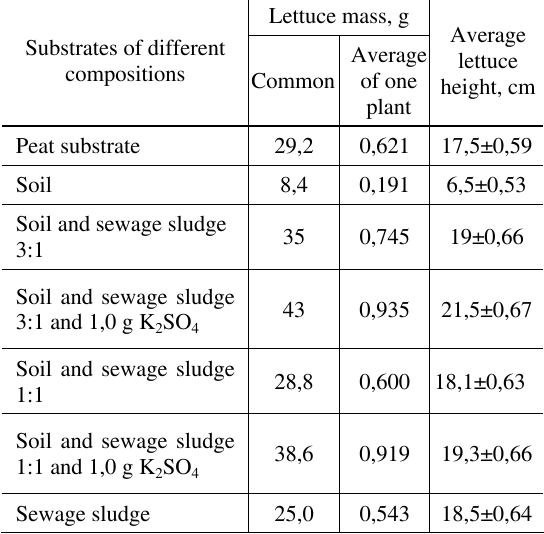
Table 2. Lettuce height, average mass of each plant and